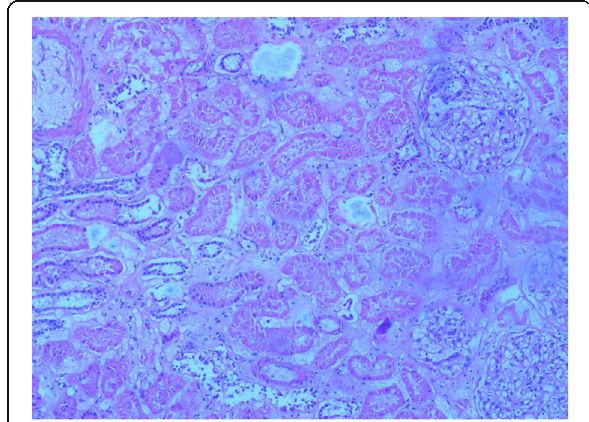
Fig. 2 Section from the kidney showing focal acute tubular